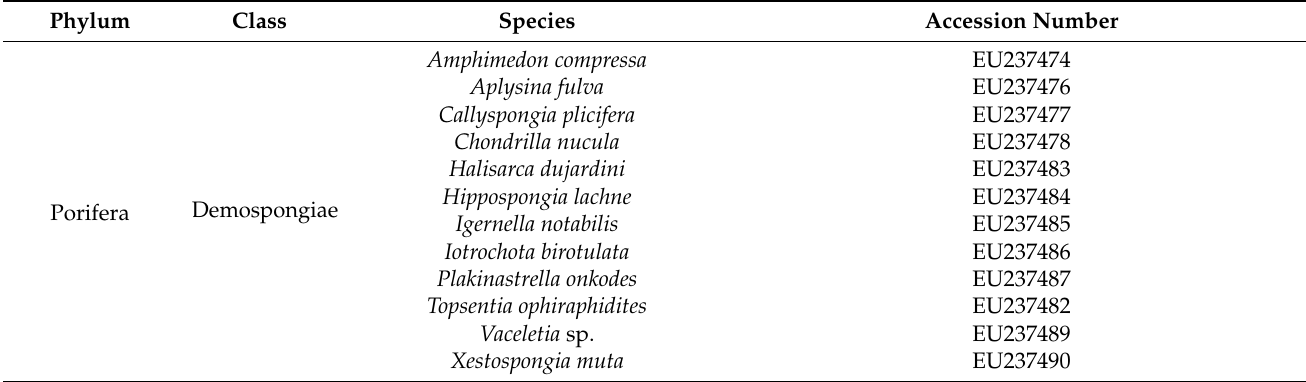
Table A1. Supplementary data on the design of B. californica -specific primers in this study.